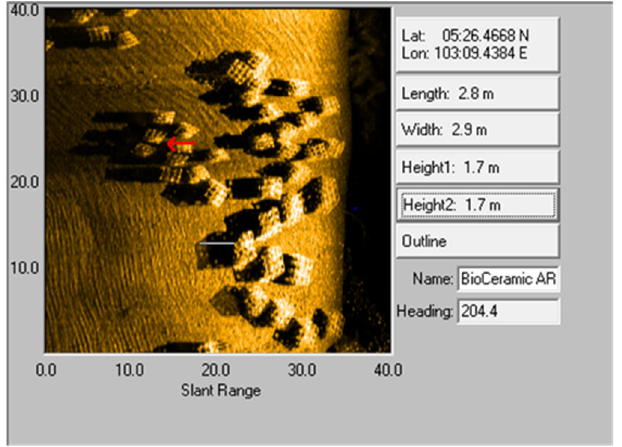
Figure 4. Measurement of height of the AR unit based on the sonar image from the side-scan Klein 4900 system acquisition interface.